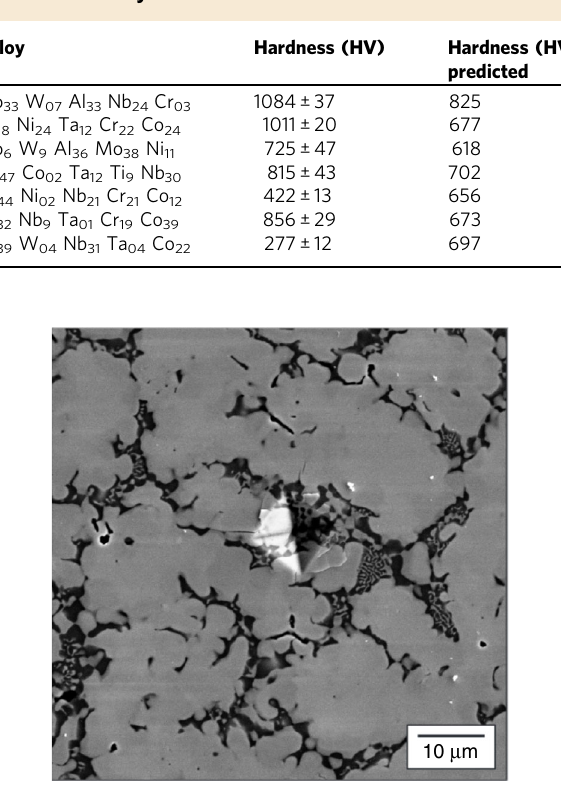
Fig. 5 Micrograph of a hard alloy. A scanning electron microscopic micrograph in a region near a microhardness indent in the Co 33 W 07 Al 33 Nb 24 Cr 03 sample that was synthesized by arc-melting. The fi gure evinces a dendritic microstructure with eutectic-like inter-dendritic regions